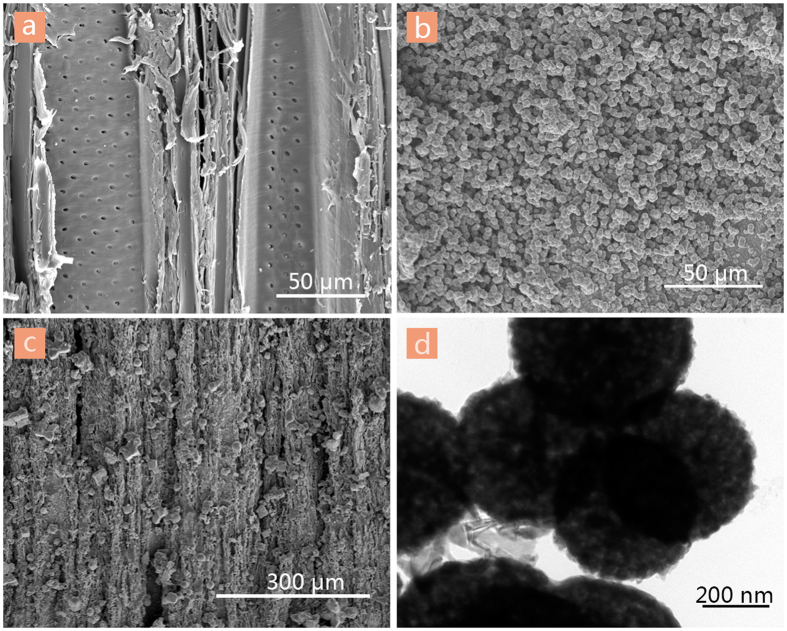
SEM images of the surfaces of (a) the original wood, (b) the TiO2-treated wood, and (c) the TiO2/Cu2O-treated wood. (d) TEM image of the TiO2/Cu2O-treated wood.